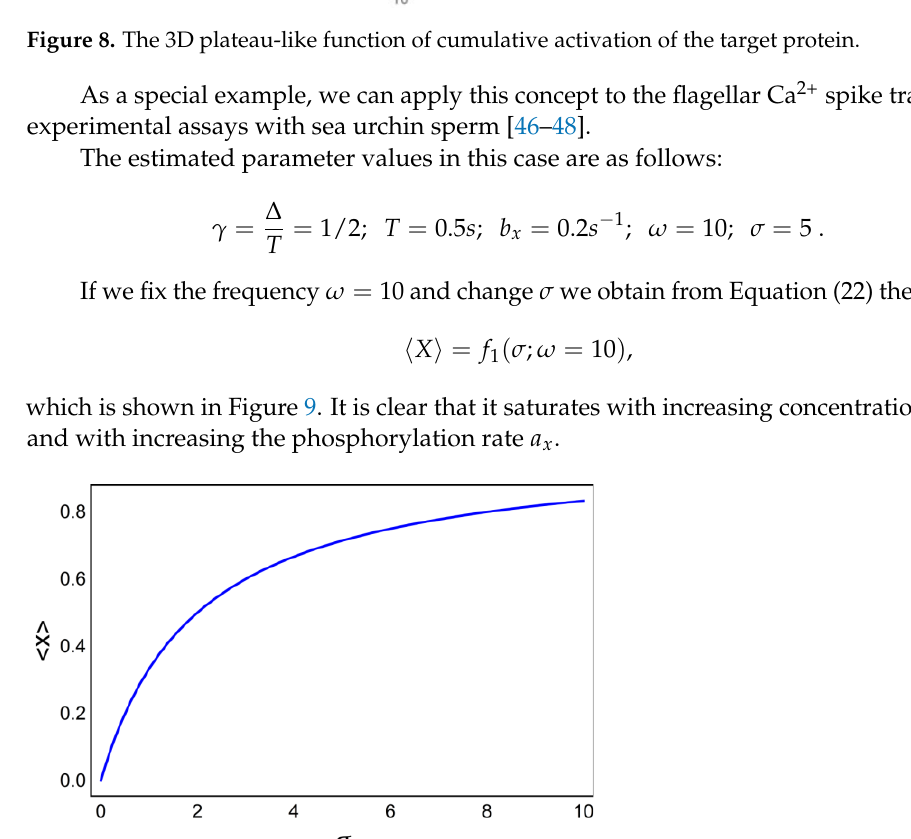
Figure 9. The cumulative activation as the function of the effective activation rate 𝜎 . Otherwise, setting 𝜎 = 5 , the cumulative activation as the function of frequency is ⟨𝑋⟩ = 𝑓 2 (𝜔; 𝜎 = 5) (28) and is presented in Figure 10.